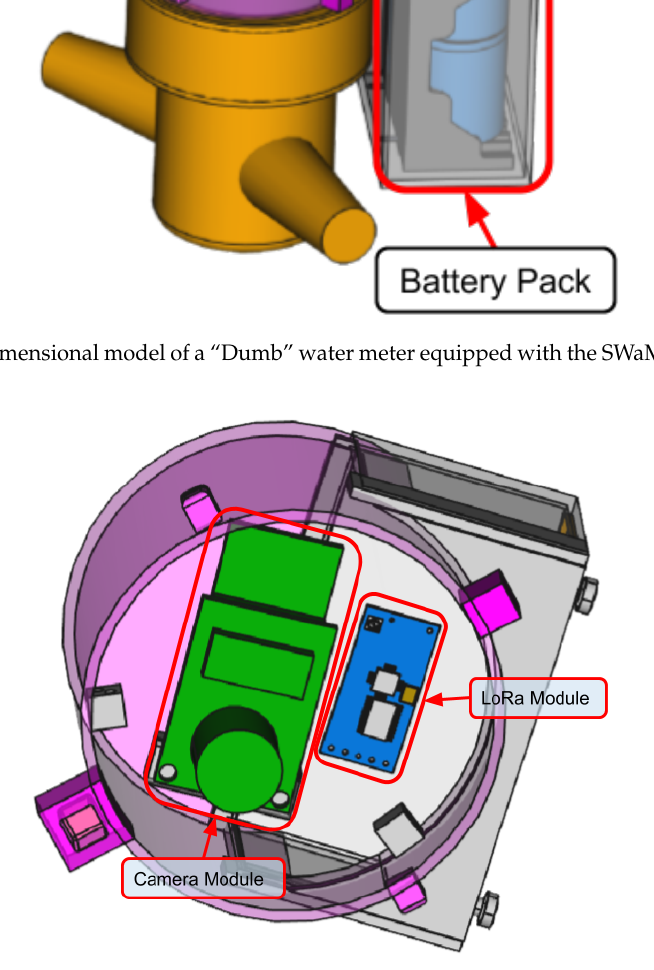
Figure 5. Three dimensional model of the SWaMM ORK